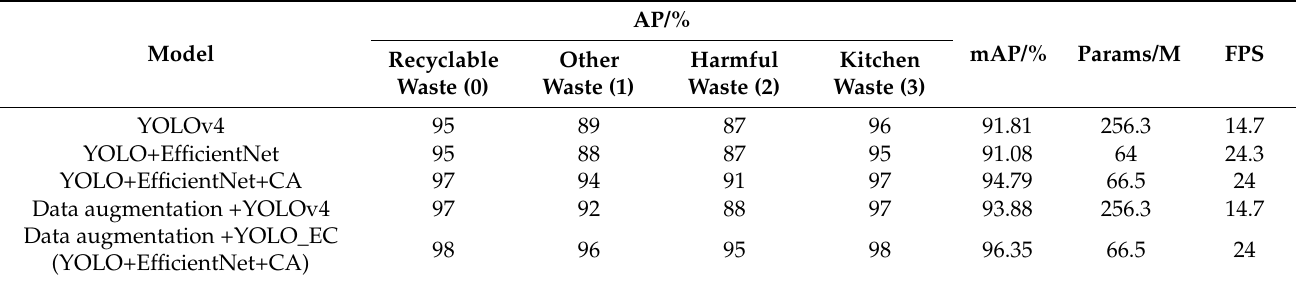
Table 3. Results of test set ablation